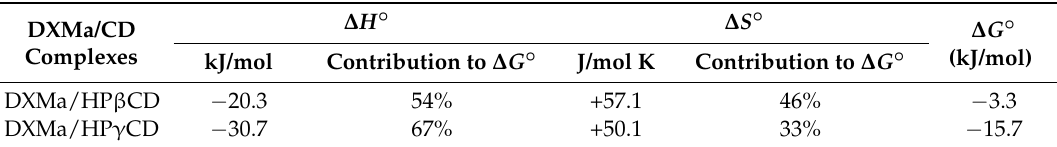
Table 5. Thermodynamic parameters ∆ H ◦ , ∆ S ◦ and ∆ G ◦ at 25 ◦ C for DXMa/HP β CD and DXMa/HP γ CD complexes. ∆ H